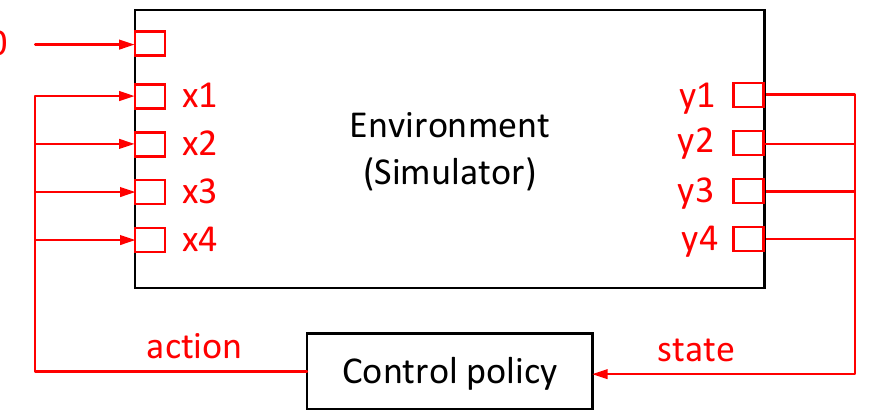
Figure 8. Vibration-control-simulation architecture.